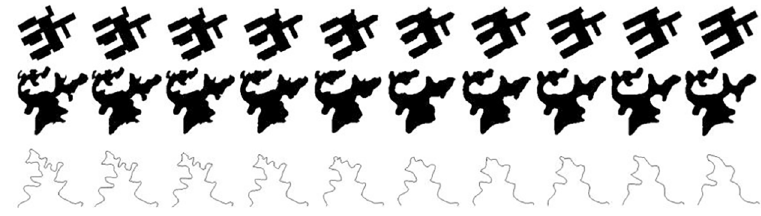
need to be reconstructed into closed curves by mirroring. Table 2 shows the relationship between the degree of approximation OD and the interceptive value n of the three sets of data. In order to ensure the accuracy of morphing, we need to set a high OD value in the process of Fourier fitting of vector data, saying OD = 0.99. When OD = 0.99, we can get the related Table 2. So for the morphing model in Formula (13), the parameters n for building feature, lake feature and linear feature are 57, 49 and 61 respectively. From the discussion in conceptual model we know that we can get representations of vector data with different resolutions by tuning the parameter g . To test the sensitivity of the morphing model to parameter g , two series of g are designed. One series are 0.1, 0.2, 0.3, 0.4, 0.5, 0.6, 0.7, 0.8, 0.9, 1, the interval of g is 0.1, and the experimental results are showed in Fig 3. The other series are 0.95, 0.94, 0.93, 0.92, 0.91, the interval of g is 0.01, and the results are showed in Fig 4. For convenience of